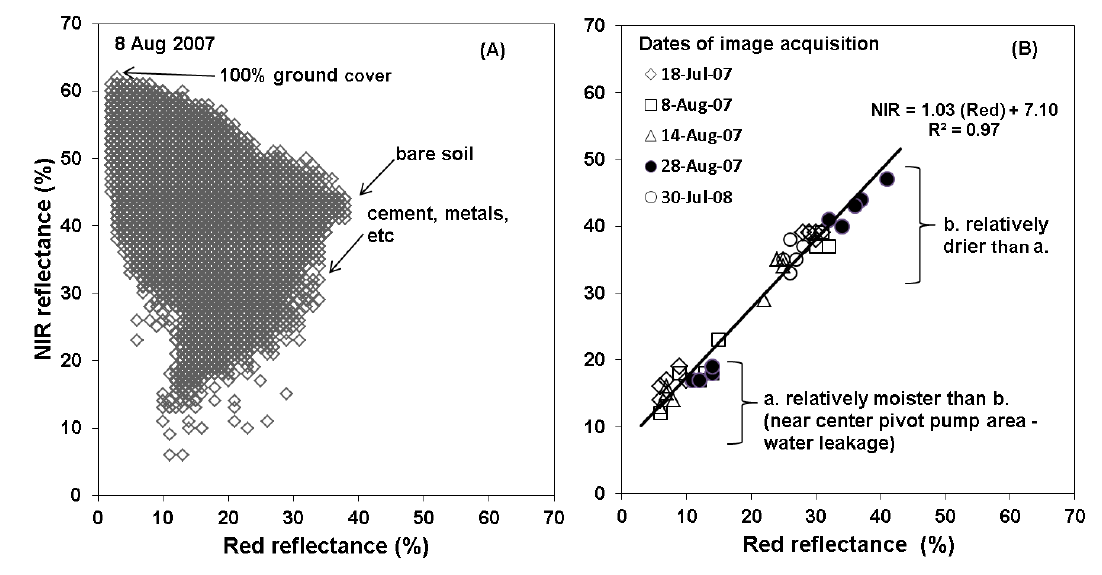
Figure 4. Red vs. NIR scatter plot of pixel reflectance from an image scene taken on 8 August 2007 ( A ), and the soil line evaluated from multi-temporal image data for georeferenced bare soil surfaces (near the pivot pump and adjacent to the plots) with varying degrees of moisture ( B